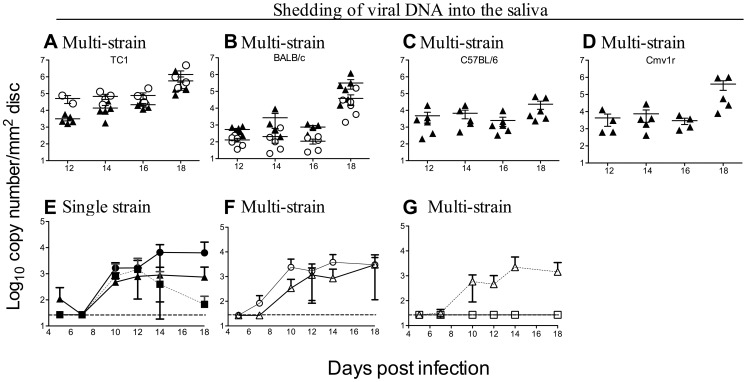
Within-host competition prevents viral shedding into the saliva.Shedding of C4A (open circles) and C4C (filled triangles) was assessed during co-infection (a total of 1×104 pfu of virus given i.p.) in A. TC1 mice, B. BALB/c mice, C. B6 mice and D. CMV1r mice. Note, both viruses were present in the saliva of Ly49H− (TC1 and BALB/c) mice, whereas C4A was excluded from the saliva of Ly49H+ (B6 and CMV1r) mice. The effect of m157 on viral shedding was also assessed. B6 mice were infected with 1×104 pfu of C4C, K181 or K181Δm157 or co-infected a total of 1×104 pfu of either C4C and K181Δm157 or C4C and K181. Shedding of virus into the saliva was assessed by qPCR E. Viral DNA in the saliva of mice infected with C4C (filled triangles), K181 (filled squares) or K181Δm157 (filled circles). All three strains of MCMV were shed into the saliva during single strain infection. F. Viral DNA in the saliva of mice co-infected with C4C (open triangles) and K181Δm157 (open circles). G. Viral DNA in the saliva of mice co-infected with C4C (open triangles) and K181 (open squares). Note both C4C and K181Δm157 were shed into the saliva of B6 during co-infection, however K181 was excluded from the saliva when co-infected with C4C. Data are mean ± SEM for 5 animals per group. Dotted line indicates limit of detection.